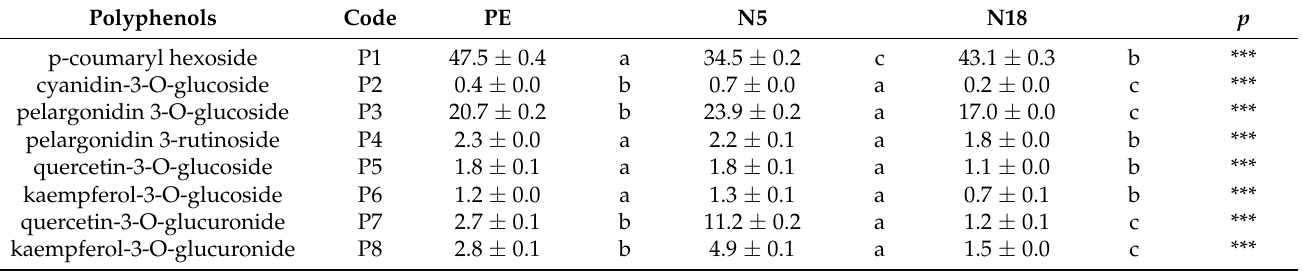
Table 4. Assignment and semi-quantitative determination of phenolic compounds (mg 100g − 1 FW) measured in strawberries cv Sabrina cultivated with three different mulch types (PE, N5, and N18).